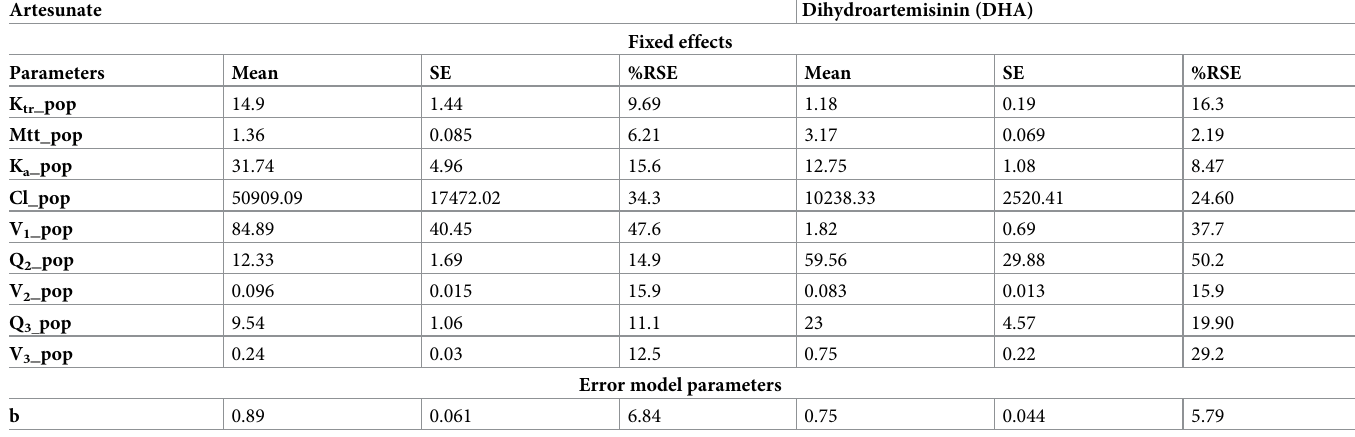
Table 2. Pharmacokinetics